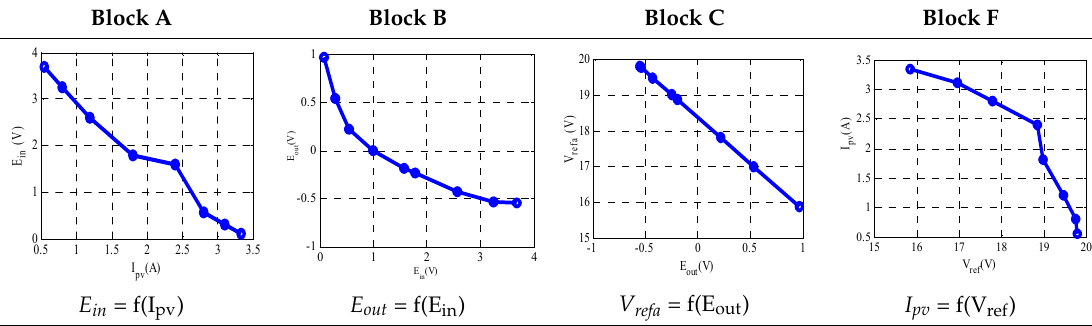
Table 2. Experimental results of the PV emulator as different block circuits.